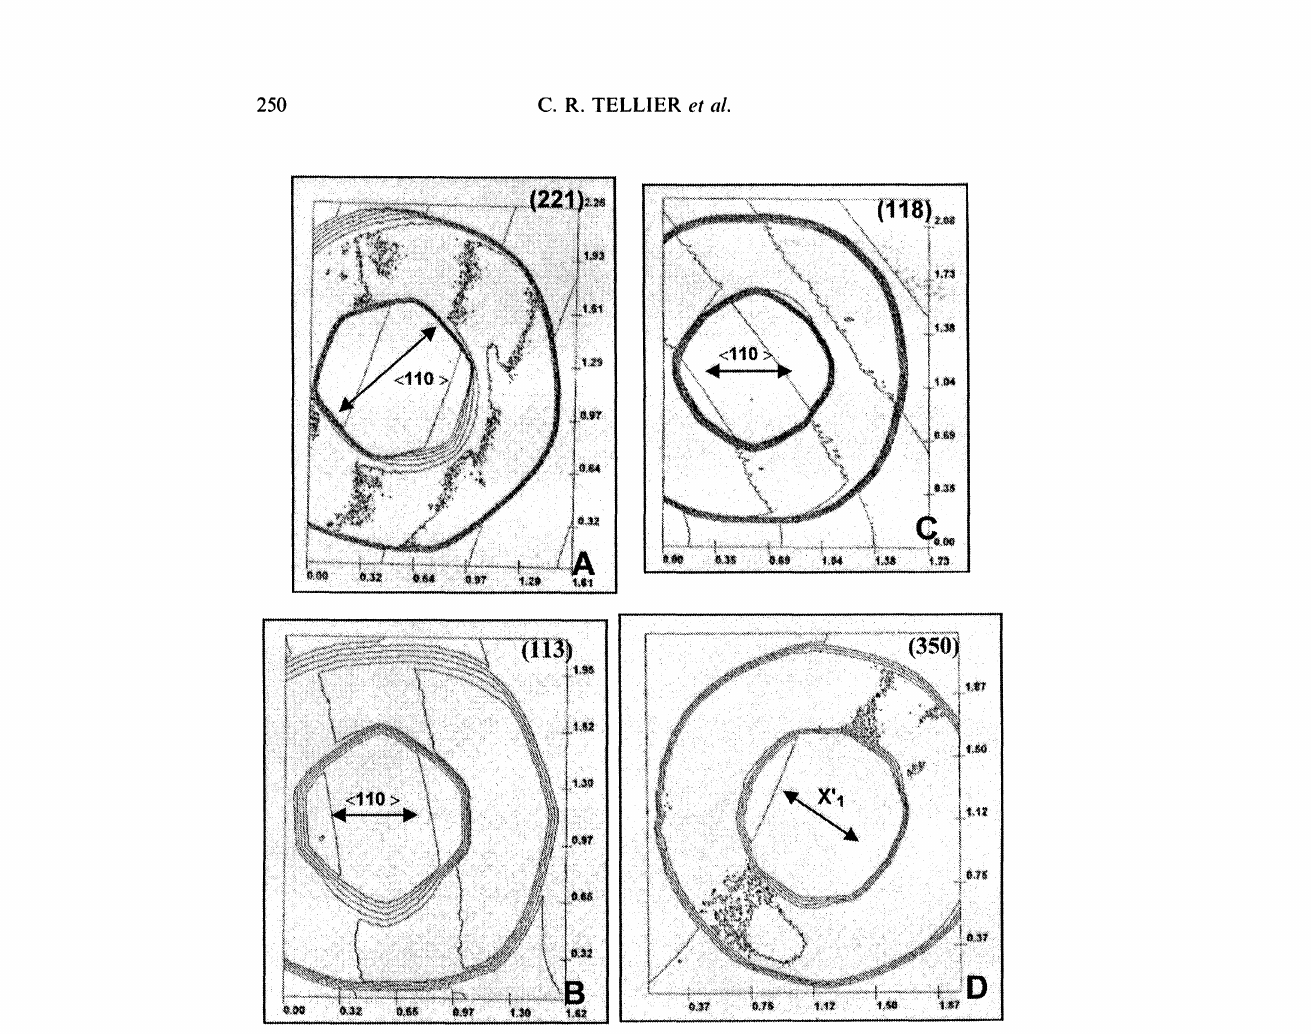
FIGURE 7 Constant-level contour diagrams of various "circular" (h h/) membrane- mesa structures, A, B, C and D are for (22 1), (1 3), (!18) and (350) structures respectively. Note that owing to the symmetry only a part of contour diagram is given for